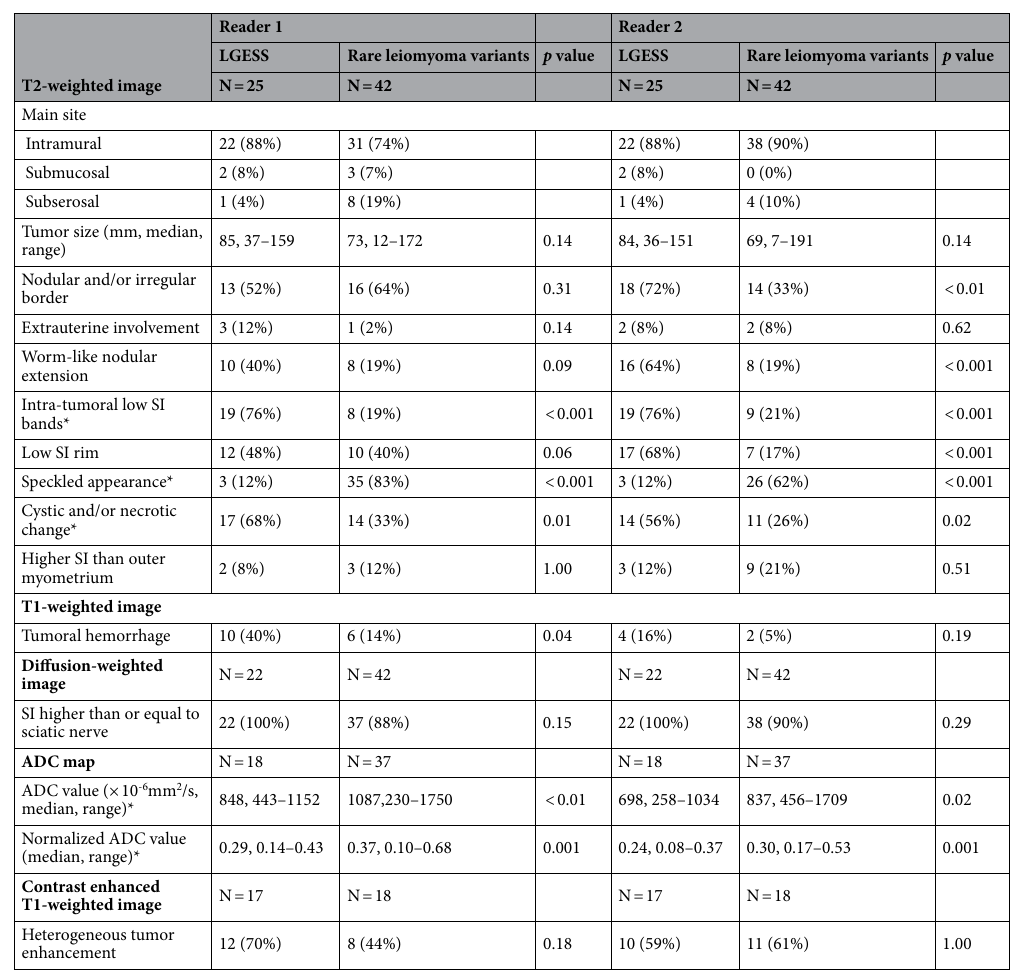
Table 2. Two readers’ evaluations of magnetic resonance imaging features. LGESS low grade endometrial stromal sarcoma, SI signal intensity, ADC apparent diffusion coefficient. * p value < 0.05 for both